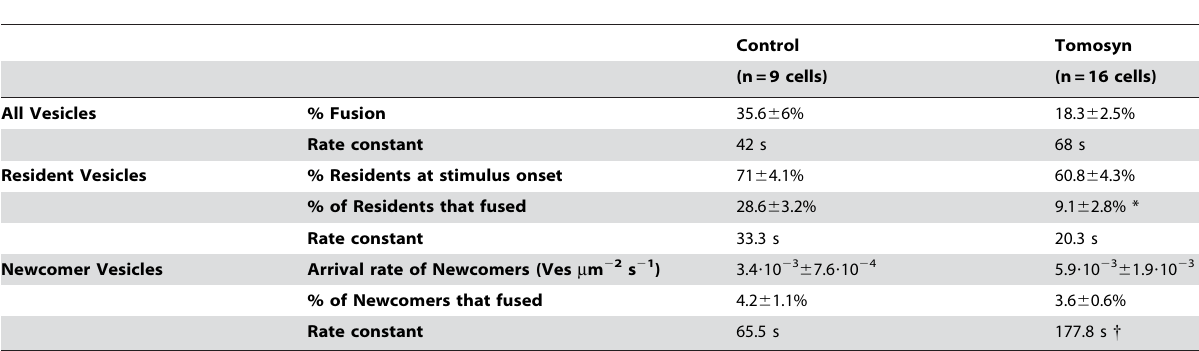
Figure 5. Exocytosis in tomosyn-overexpressing cells occurs mostly from a pool of newcomer vesicles. (a) . Kymograph plot for vesicles secreted in control cells (n=73 vesicles from 9 cells). Stimulation period is indicated by red background. (b) . Lifetime plot for vesicles secreted in tomosyn-overexpressing cells (n=96 vesicles from 16 cells). (c) . Average proportion of resident and newcomer vesicles secreted in control and tomosyn-overexpressing cells. (d) . Average cumulative fusion plot, normalized to the amount of vesicles visible before stimulation, for control cells. Total secretion, and secretion of resident vesicles and of newcomer vesicles are indicated by black, magenta and green lines, respectively. Dotted red lines represent exponential fits to the data. See Table 2 for rate constants. t = 0 is the onset of stimulation. (e) . Average cumulative fusion plot, normalized to the amount of vesicles visible before stimulation, for tomosyn-overexpressing cells. Total secretion, secretion of resident vesicles and of newcomer vesicles are indicated by black, magenta and green lines, respectively. Dotted red lines represent exponential fits to the data. See Table 2 for rate constants. t = 0 is the onset of stimulation. (f) . Average total normalized secretion in control and tomosyn-overexpressing cells, expressed as the fraction of the amount of vesicles in the TIRF plane prior to stimulation. doi:10.1371/journal.pone.0002694.g005 Table 2. Fusion of resident and newcomer vesicles in control and tomosyn overexpressing